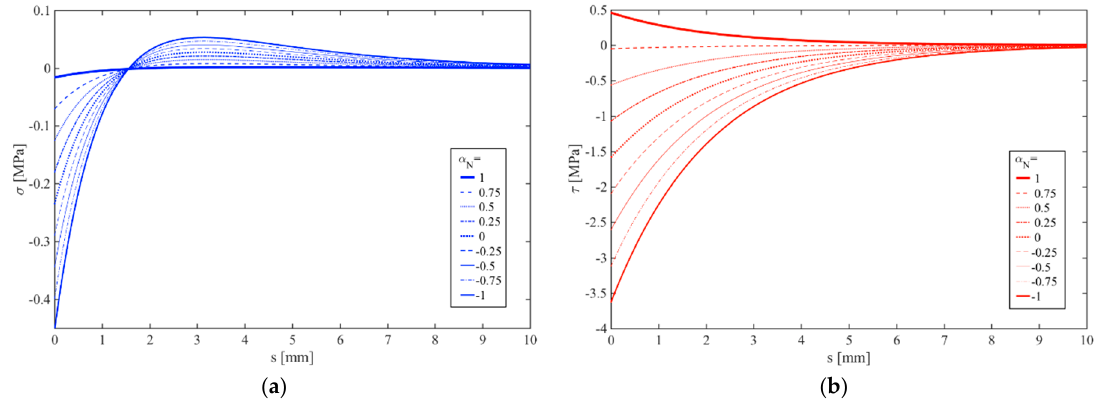
Figure 8. Effect of the axial loading on the interface local response: ( a ) Normal stress; ( b ) Tangential stress. (Orthotropic specimen).